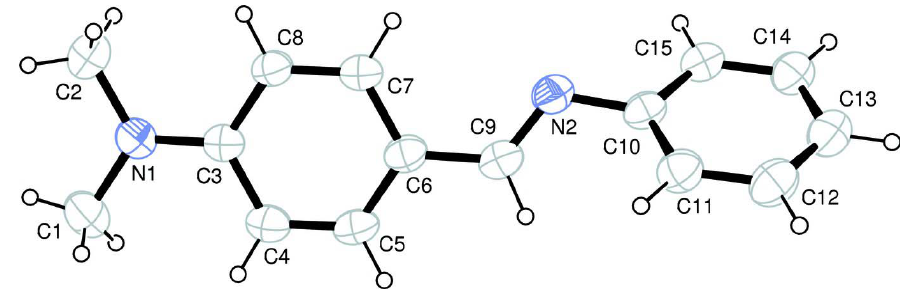
sup-1 Acta Cryst. (2009). E 65 , o506